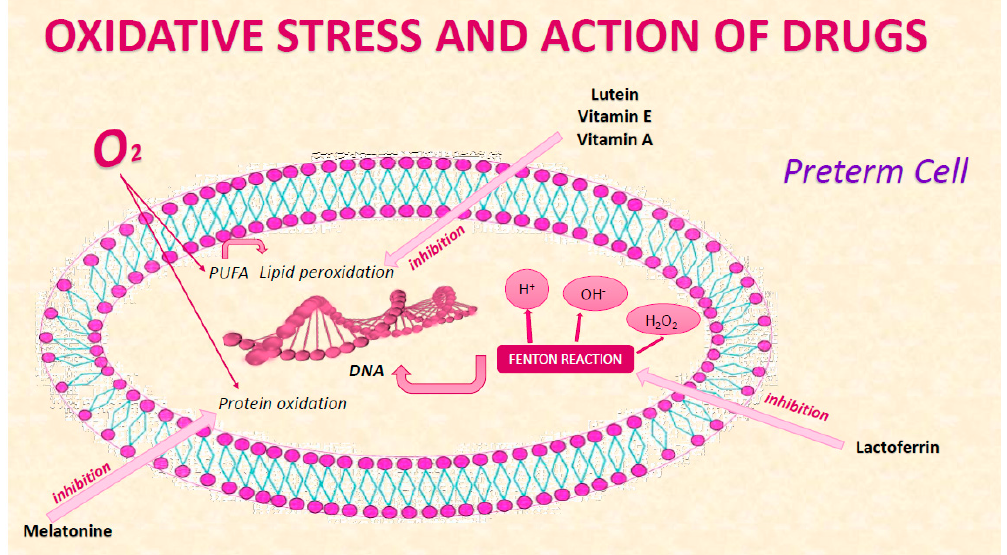
Figure 2. Drug action on cellular oxidative stress of preterm.